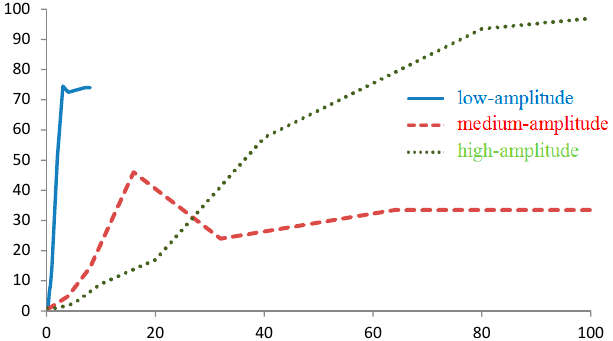
Figure 6. Dependence of the number of found potential points on the N potential route on the measurement error (mGal) for one route point when navigating by the intersection of three projections of the g vector for the case of regions with low-, medium-, and high-amplitude gravity